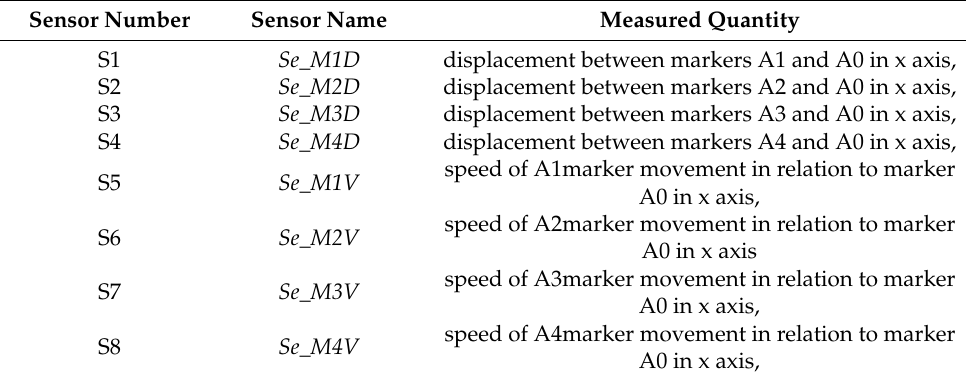
Table 2. Description of the sensors introduced to the